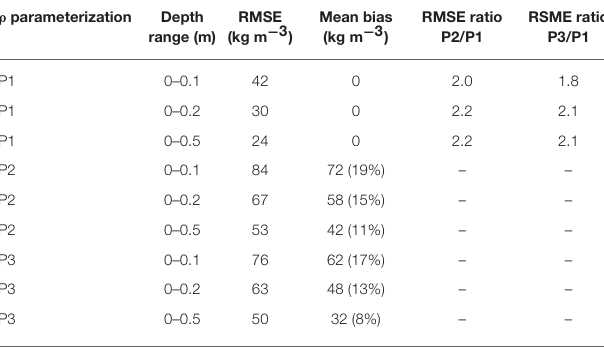
TABLE 3 | Root-mean-square error (RMSE), mean bias and RMSE ratio values for parameterizations using annual mean air temperature: P1 (this study), P2 (Kuipers Munneke et al., 2015) and P3 (Reeh et al.,